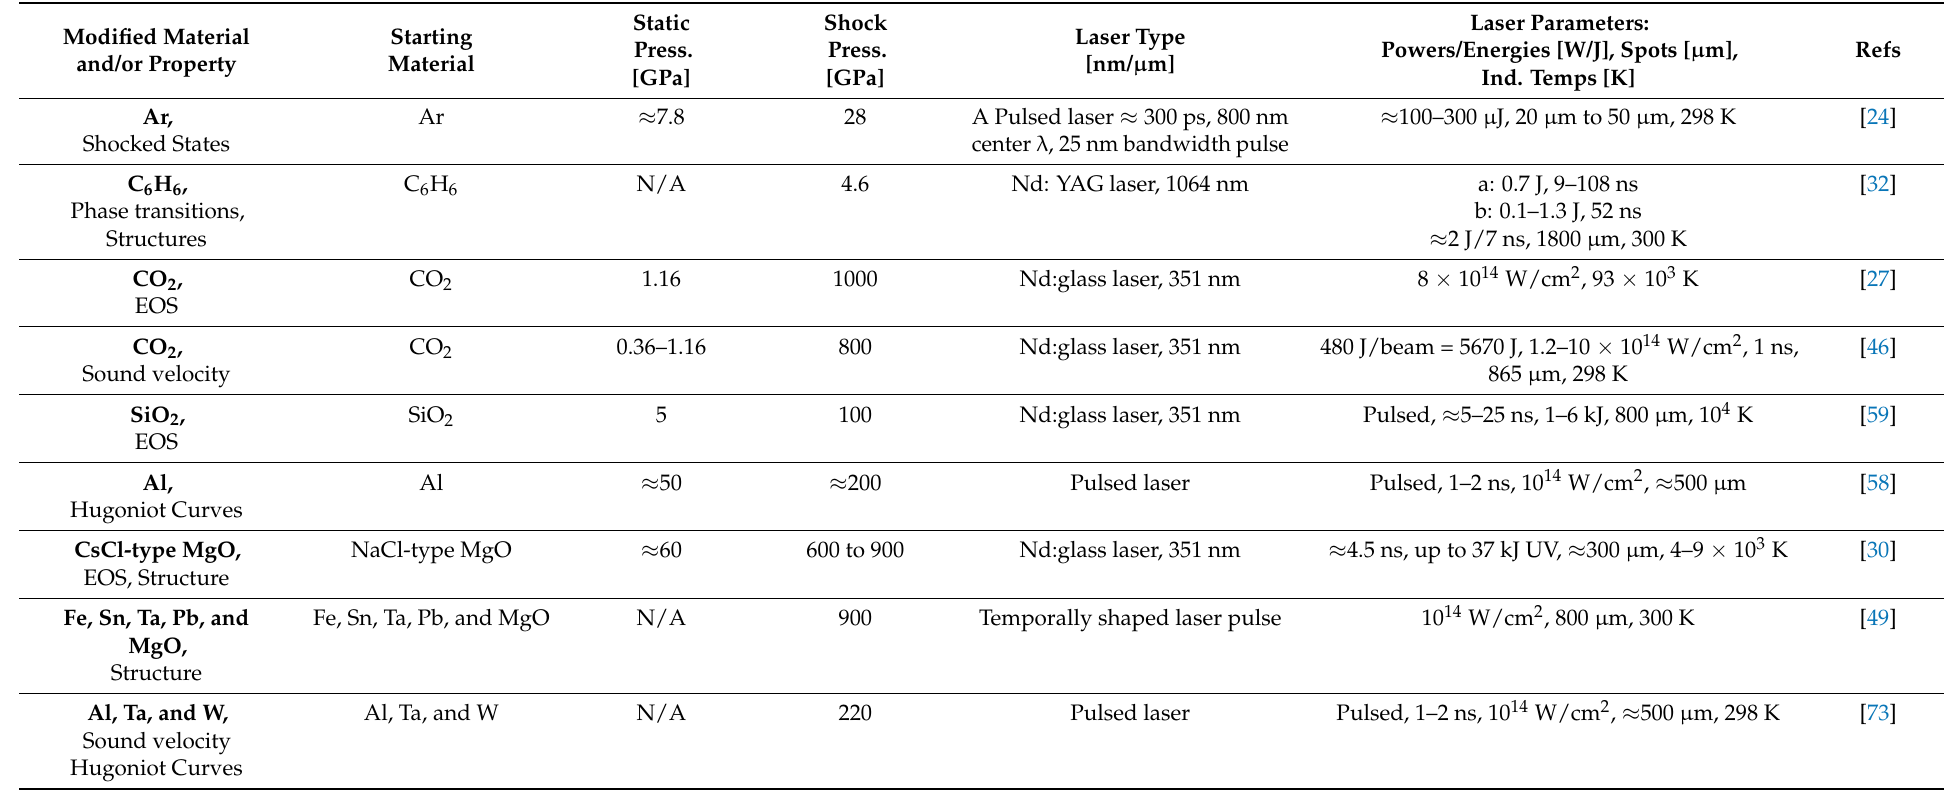
Table 2. High-Z materials/minerals modified in selected LDC–DAC